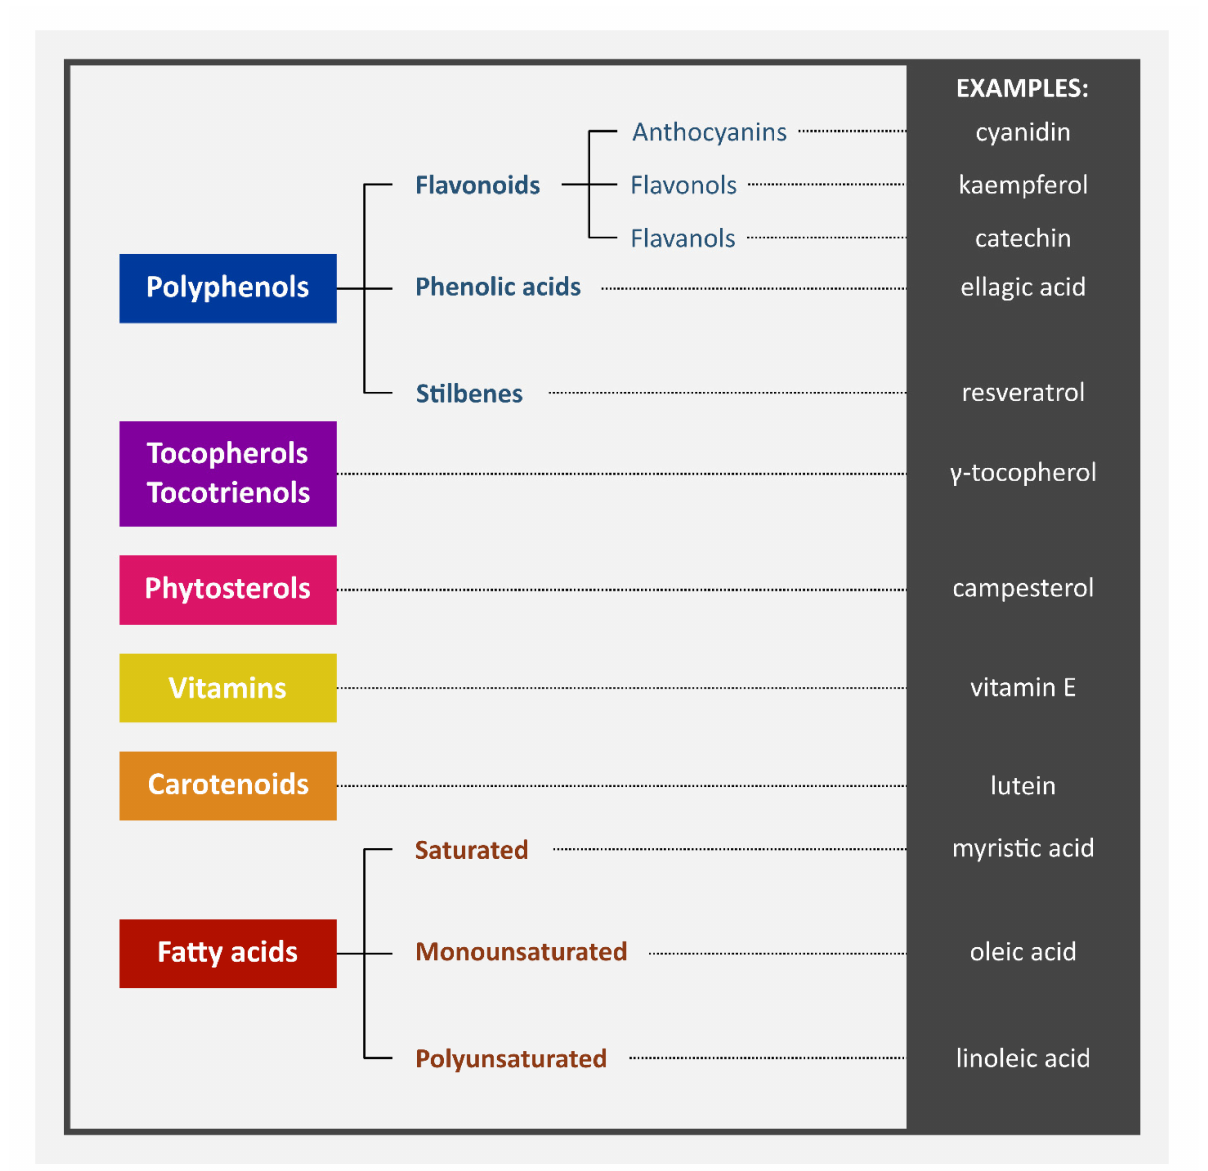
Figure 1. Main groups of chemical compounds (including secondary metabolites) in berry seeds. Compilation of data: